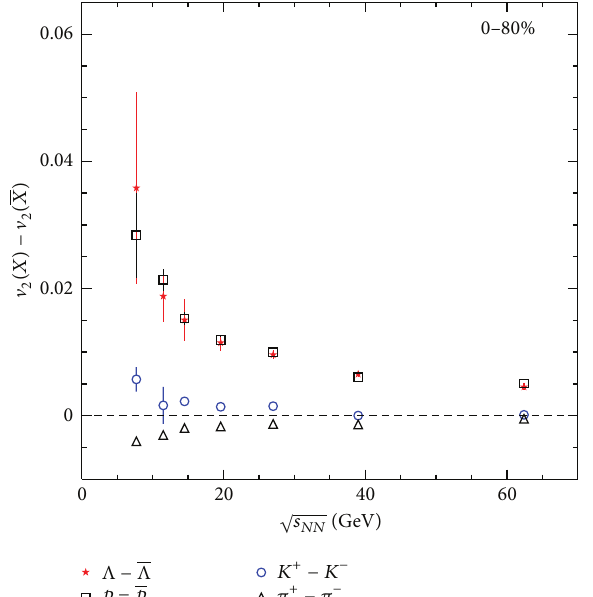
Figure 6: The difference in V 2 between particles ( 𝑋 ) and their corresponding antiparticles ( 𝑋 ) as a function of beam energy for 0– 80% central Au + Au collisions [32, 39].